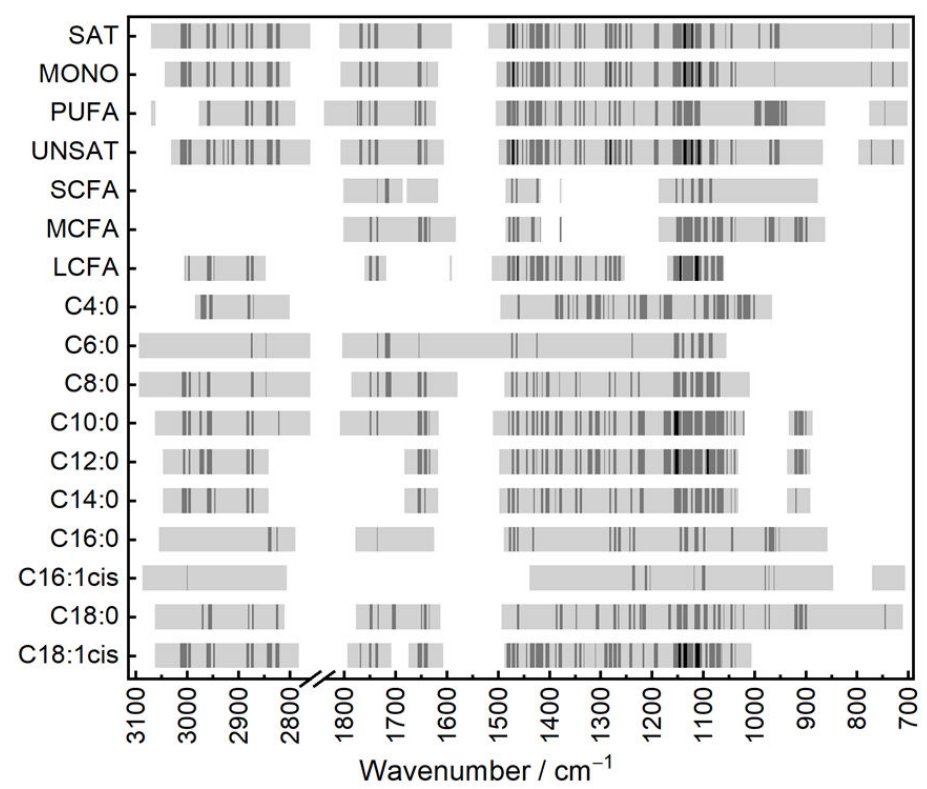
Figure 3. Heatmap, showing spectral regions included for each PLS model in greyscale. Bright grey: selectivity ratio (SR) = 0–0.5; dark grey: SR = 0.5–5; black: SR = 5–15. The spectral range between 1850 and 2750 cm − 1 was removed due to lack of relevant information. SAT: saturated fatty acids; MONO: monounsaturated fatty acids; PUFA: polyunsaturated fatty acids; UNSAT: unsaturated fatty acids; (C4–C10); MCFA: medium-chain fatty acids (C12–C16); LCFA: long-chain fatty acids (C17 and